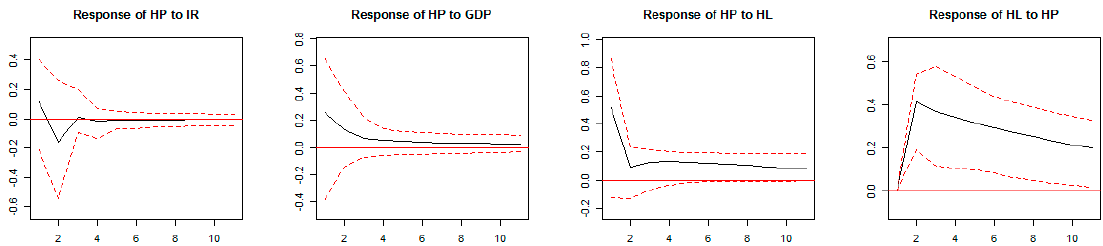
Figure 7. Impulse response based on the standard TVP model for (IR, GDP HL, HP). Notes: This shows the impulse response based on the standard VAR model for the variable set (IR, GDP, BC, HP); the solid line refers to posterior mean, and the dotted line refers to 95% credible intervals.